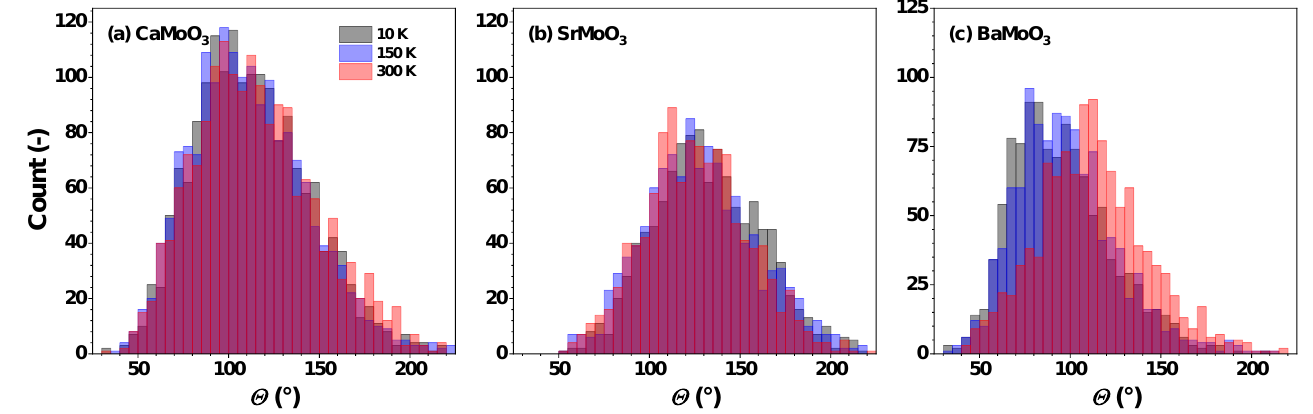
Figure 10. Histograms of calculated Θ values (Equation (3)) describing the torsional distortion of [MoO 6 ] octahedra in polycrystalline ( a ) CaMoO 3 , ( b ) SrMoO 3 , and ( c ) BaMoO 3 at 10 K, 150 K, and 300 K. See text for